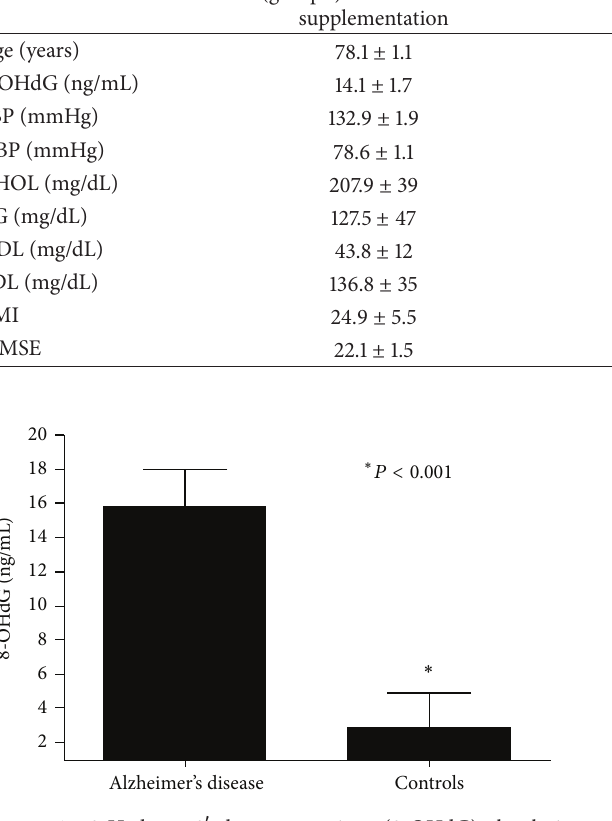
Figure 3: 8-Hydroxy-2 󸀠 -deoxyguanosine (8-OHdG) level in each of the 20 patients with Alzheimer’s disease (group 1) before and after fermented papaya powder (FPP)